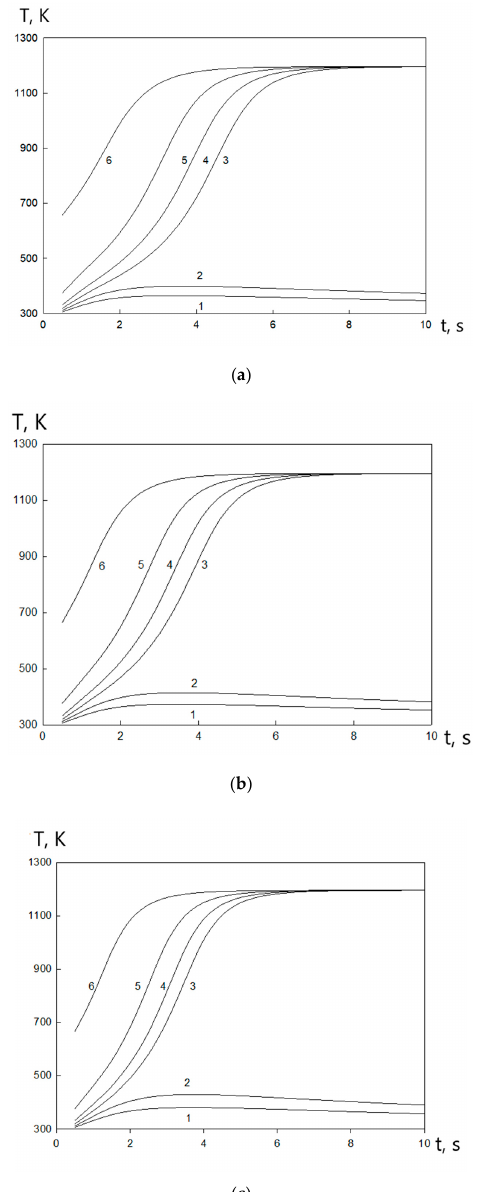
Figure 9. Temperature as a function of time: ( a ) point A, ( b ) point B, ( c ) point C, L = 50 mm, H = 5 mm, 1 – D = 6 mm, 2 – D = 8 mm, 3 – D = 10 mm, 4 – D = 12 mm, 5 – D = 14 mm, 6 – D = 16